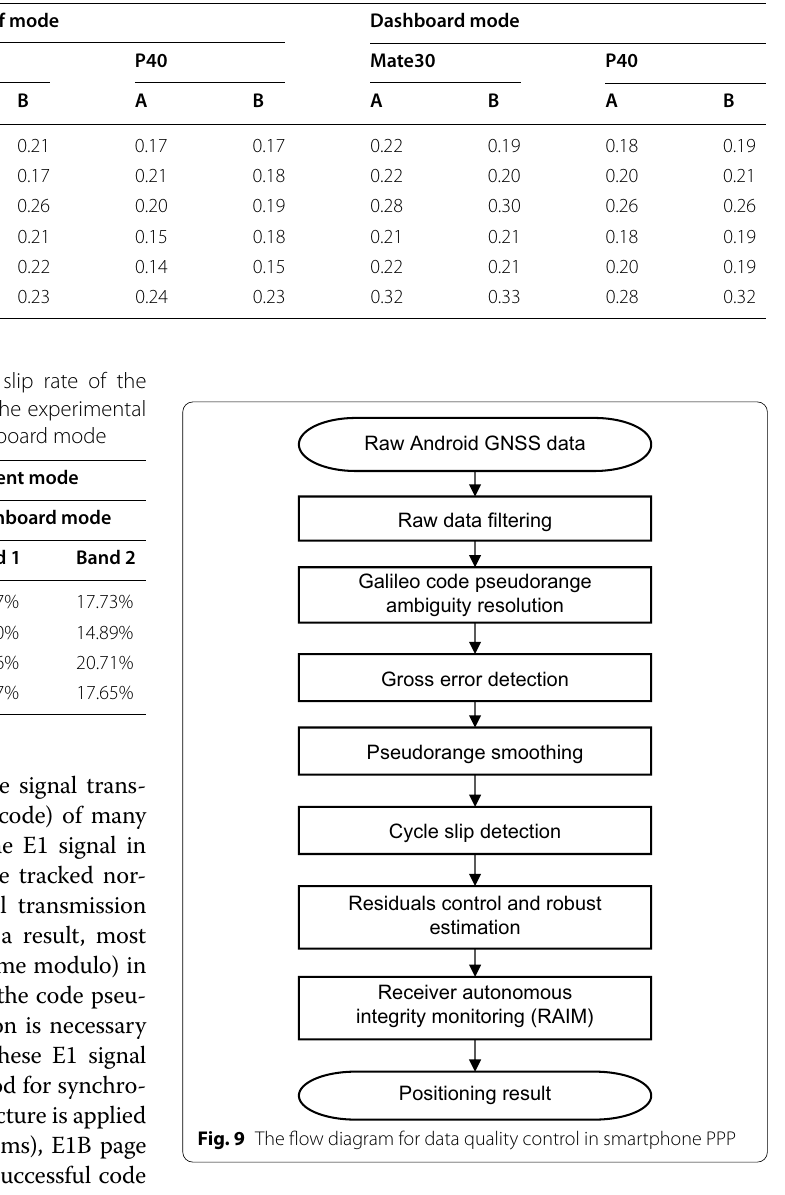
pseudorange derivative and Doppler. If the difference measurement is regarded as "affected by gross error".